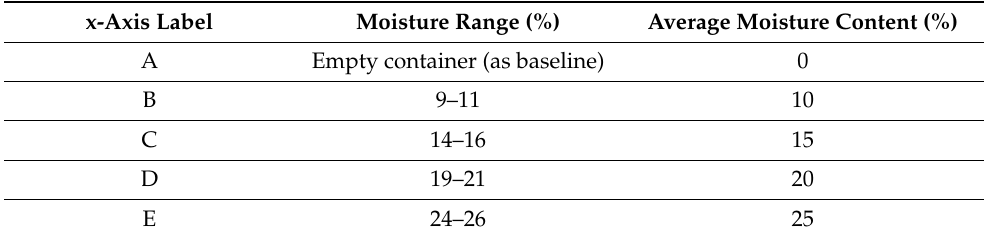
Table 4. Labels used for moisture content ranges.